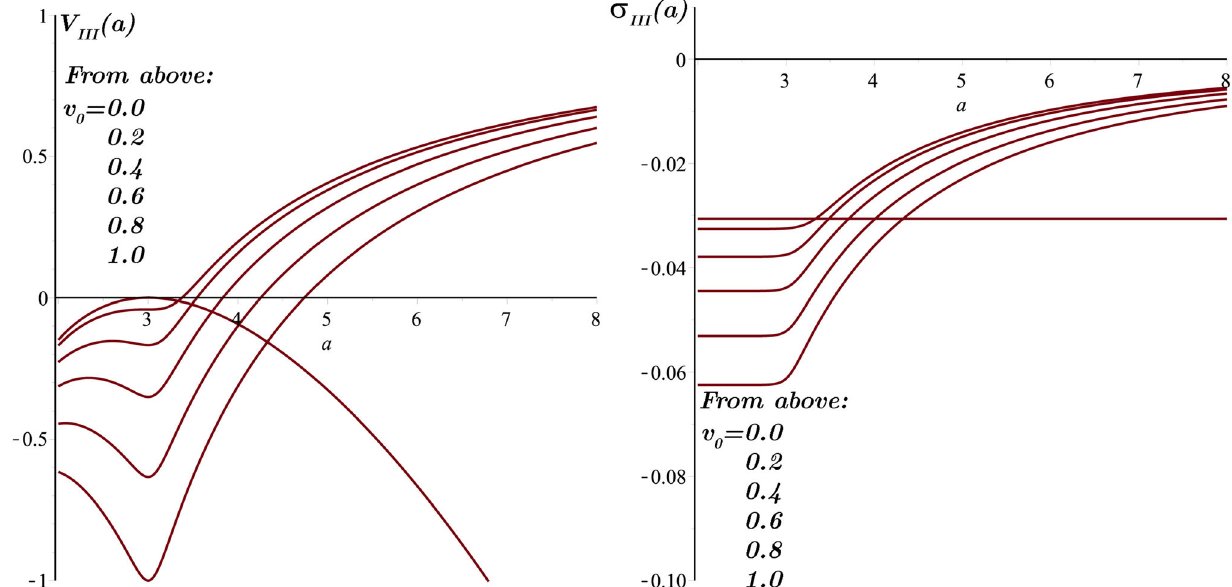
= − 16, M = 1 and from above v 0